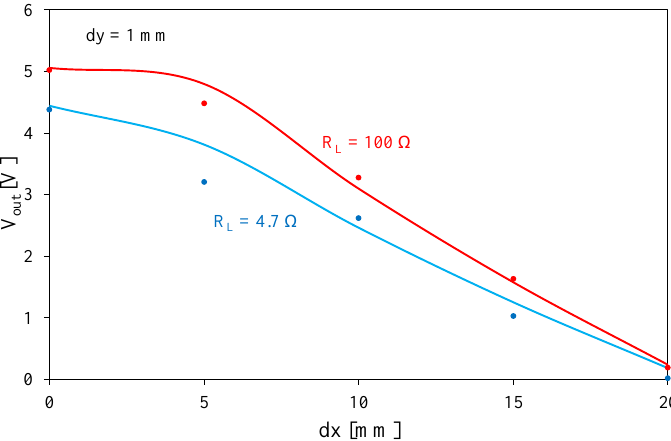
Figure 17. Dependence of the output voltage on load resistance at selected values of distance dy between the coils.